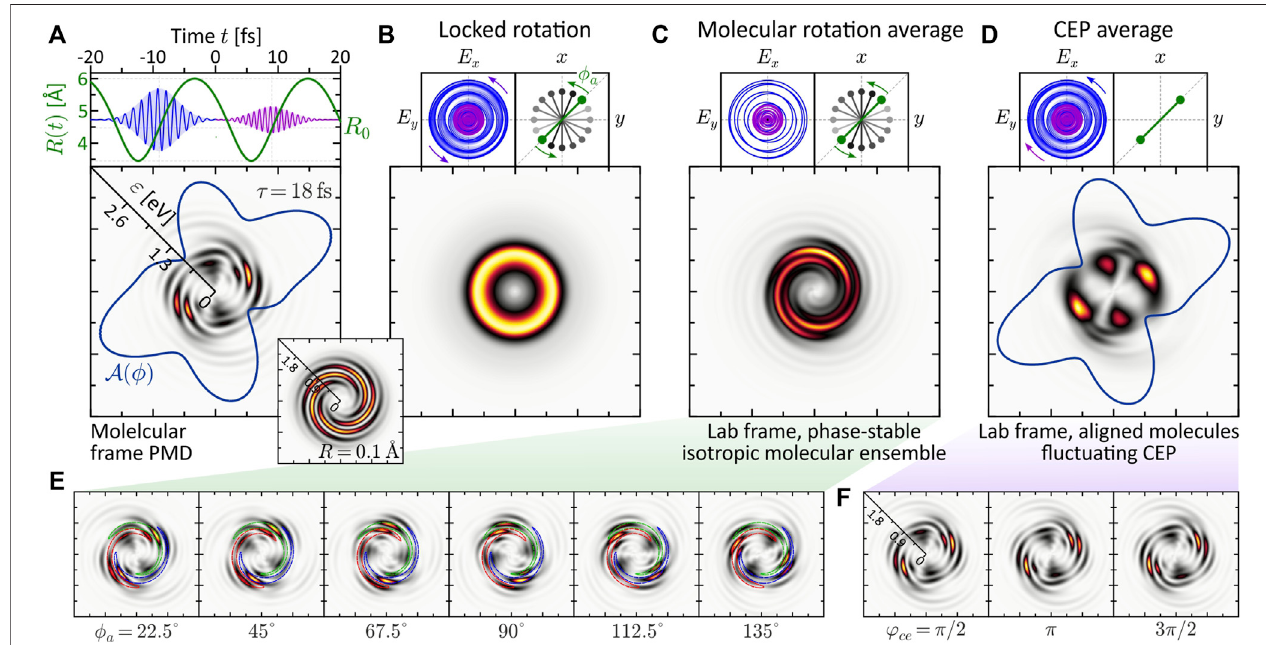
FIGURE8| (Coloronline.)In fl uenceofexperimentalconditionsonamolecularFEVcreatedbydynamictwo-vs.three-photonionizationusinganLRCPbichromatic (2 ω :3 ω )pulsesequence.Allframesshowenergy-calibrated2DPMDs. (A) ThemolecularframePMDcreatedbyaphase-stable fi eldexhibitsanintricate fi ve-armedspiral pattern. (B) Rotating both the molecule and the fi eld about the laser propagation direction washes out the interference pattern completely and yields an isotropic, torus- shaped PMD in the lab frame. (C) Lab frame PMD obtained for an isotropic molecular ensemble and a phase-stable pulse sequence. Surprisingly, the highly structured fi ve-armed FEVtransforms intoaregularlyshapedthree-armedArchimedean spiral. (D) LabframePMDobtainedforanensembleofalignedmoleculesanda fl uctuatingCEP.TheCEPcontrolstherotationofthebichromatic fi eld. (E,F) showselectedsubsetsofmolecularframePMDsunderlyingthemolecularrotationaveraging and the CEP-averaging procedure,